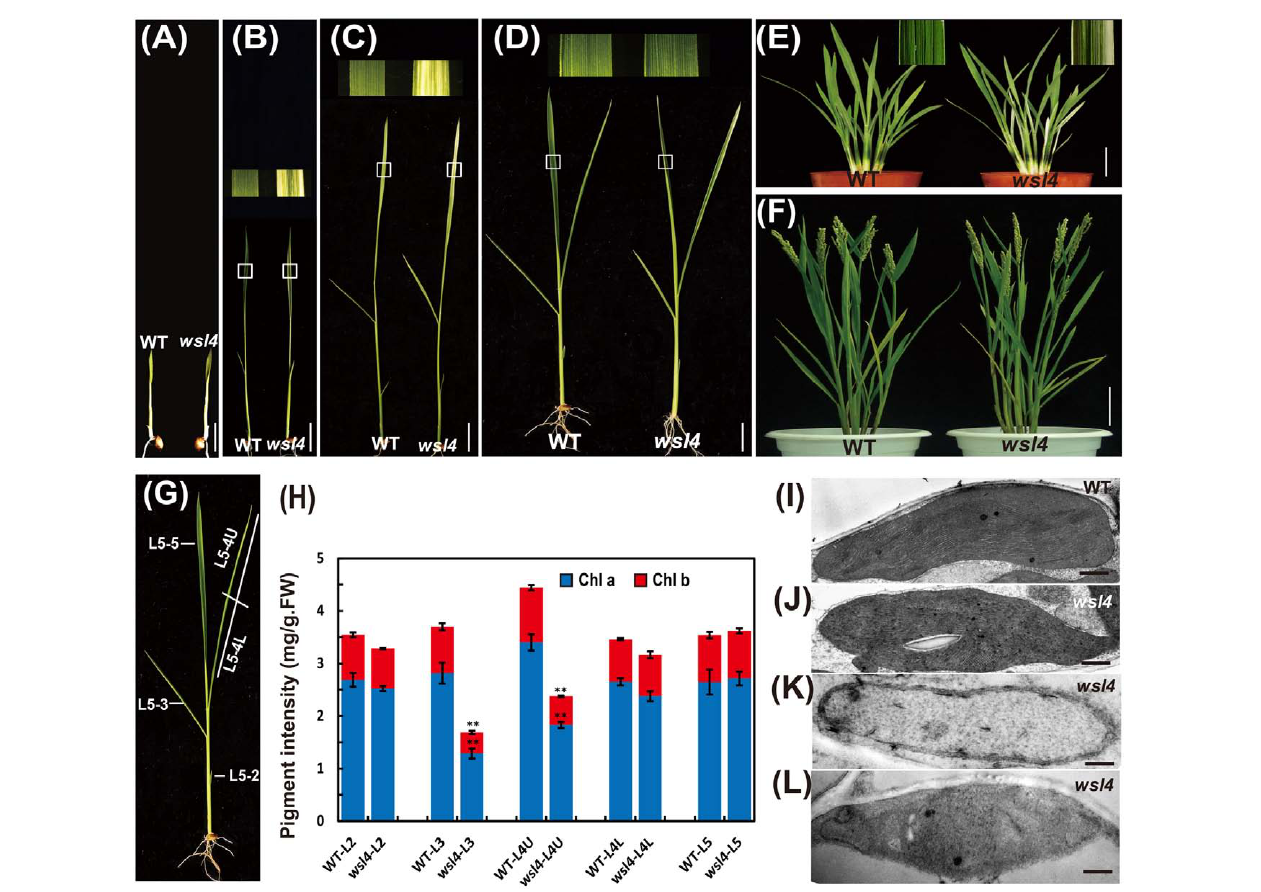
FIGURE 1 | Phenotypic comparison of WT and wsl4 mutant plants. Comparisons of leaves of WT and wsl4 mutant plants grown in a growth chamber with a 12 h photoperiod at 30 ◦ C/25 ◦ C (L30/D25) at the two- (A) , three- (B) , four- (C) , and five- leaf (D) stages. The insets represent magnified views of the selected areas in (B–D) . Bars, 0.5 cm. (E,F) Leaves of WT and wsl4 mutant plants grown in field at the tillering stage (E) and after heading stage (F) . Note the white-striped leaves from the tillers of the wsl4 mutant at the tillering stage. Bars, 5 cm (E) ; 10 cm in (F) . (G) A rice shoot with fully emerged fifth leaf at the five-leaf stage. L5-2, L5-3, L5-4, and L5-5 represent the second, third, fourth, and fifth leaf at the five-leaf stage, respectively. (H) Measurements of chlorophyll a and b contents of all leaves (L5-2, L5-3, L5-4U, L5-4L, and L5-5) from five-leaf stage WT and wsl4 mutant plants grown in a growth chamber at L30/D25. L5-4U represents the upper half of the fourth leaf, and L5-4L represents the basal half of the fourth leaf. Values are means ± SD from three independent repeats. Student’s t -test: ∗ P < 0.05; ∗∗ P < 0.01. Chl a, chlorophyll a, Chl b, chlorophyll b, FW, fresh weight. (I–L) Electron micrographs of chloroplasts from L3-3 of WT (I) and wsl4 mutant (J–L) plants grown in a growth chamber at L30/D25. Chloroplasts from the WT plants (I) and chloroplasts from the green portions of the wsl4 mutant (J) plants have abundant and well-ordered thylakoids and stacked membranes, whereas chloroplasts from white striped sectors of the wsl4 mutant plants had almost no normal stacked membrane structures (K,L) . L3-3 indicates the third leaf at the three-leaf stage. Bars, 0.5 µ m (I,J,L) ; 0.2 µ m in (K) .